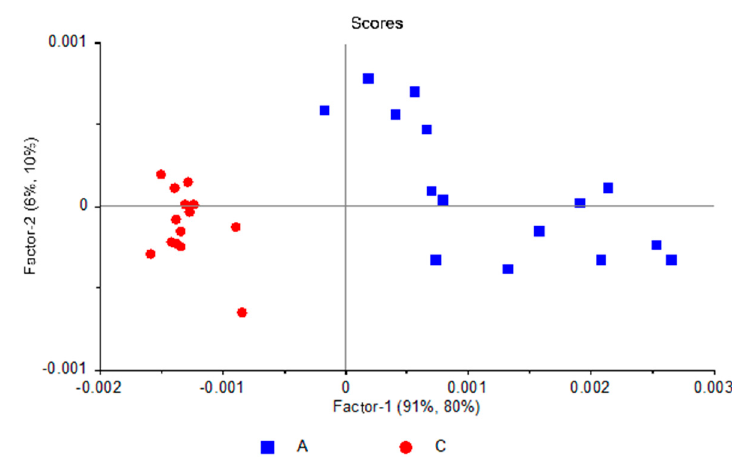
Figure 5. Scores plot (Factor-2 vs. Factor-1) for the PLSModel.